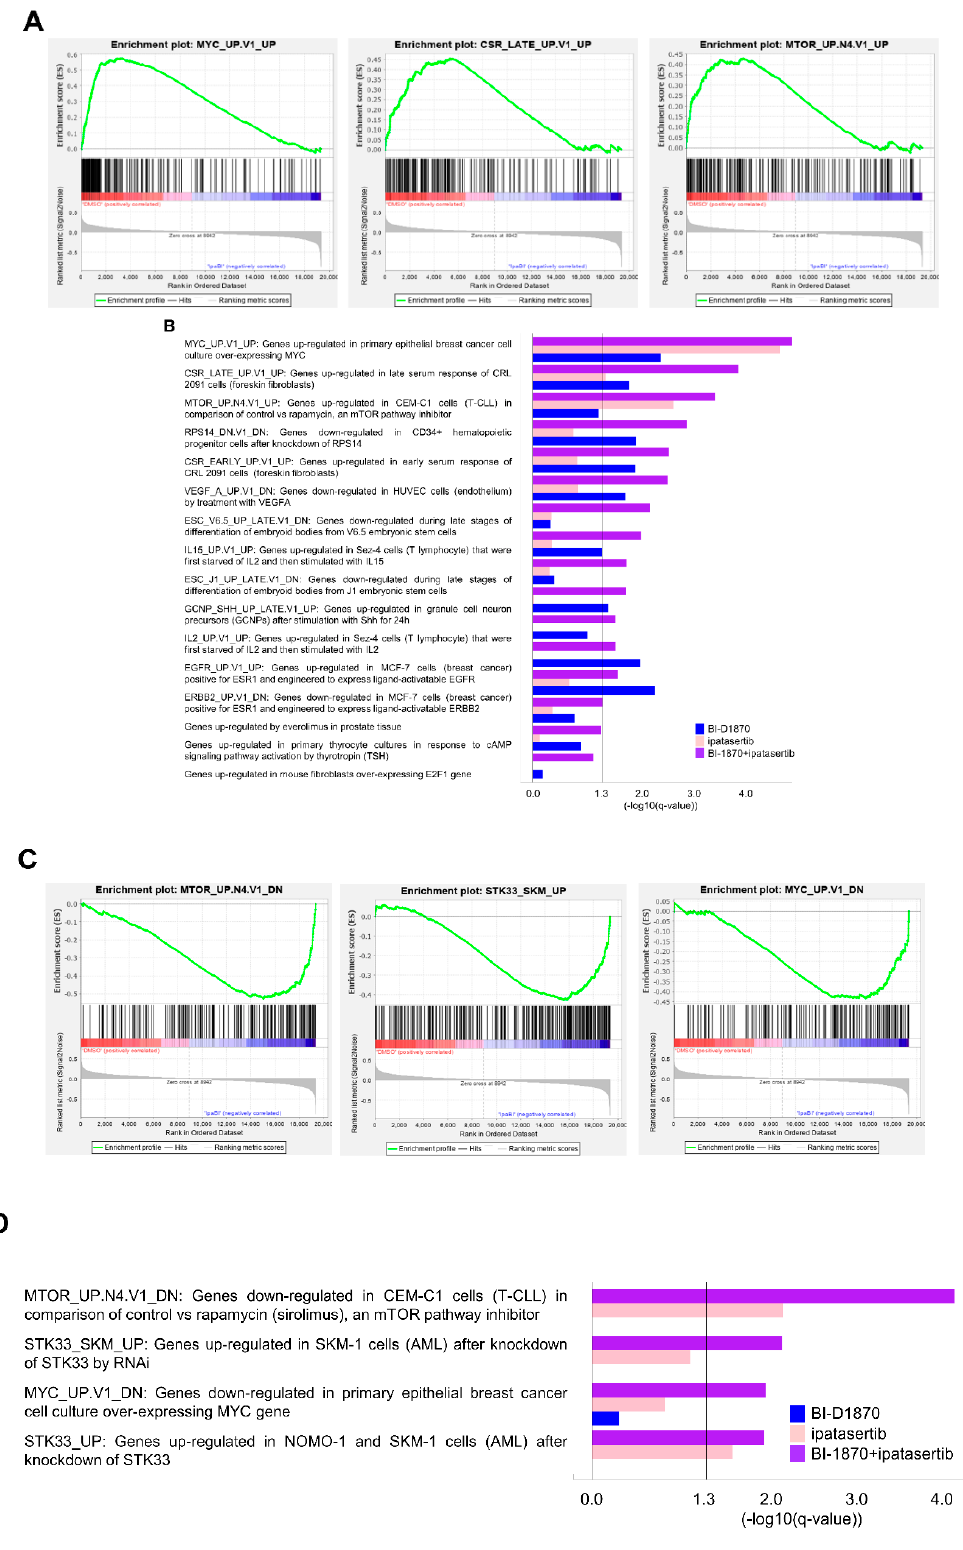
Figure 5. Functional assessment of gene sets significantly modulated either by BI-D1870, ipatasertib, or their combination in HMCLs: ( A ) Plots for top 3 significantly enriched gene sets, MYC_UP.V1_UP (left), CSR_LATE_UP.V1_UP (middle), and MTOR_UP.N4.V1_UP (right) (www.gsea-misgdb.org/gsea/index.jsp, accessed on 1st December 2021), consisted of genes downregulated by the combination of BI-D1870 and ipatasertib in NCI-H929 and OPM-2 cells. ( B ) List of downregulated gene sets that are more significantly enriched by the combination treatment of BI-D1870 and ipa- tasertib compared to the treatment by either BI-D1870 or ipatasertib alone. Significance was shown by false discovery rate (FDR)(q-value) scores. − log10(FDR-q-value) score bigger than 1.3 is signifi- cant. ( C ) Plots for top 3 significantly enriched gene sets, MTOR_UP.N4.V1_DN (left),